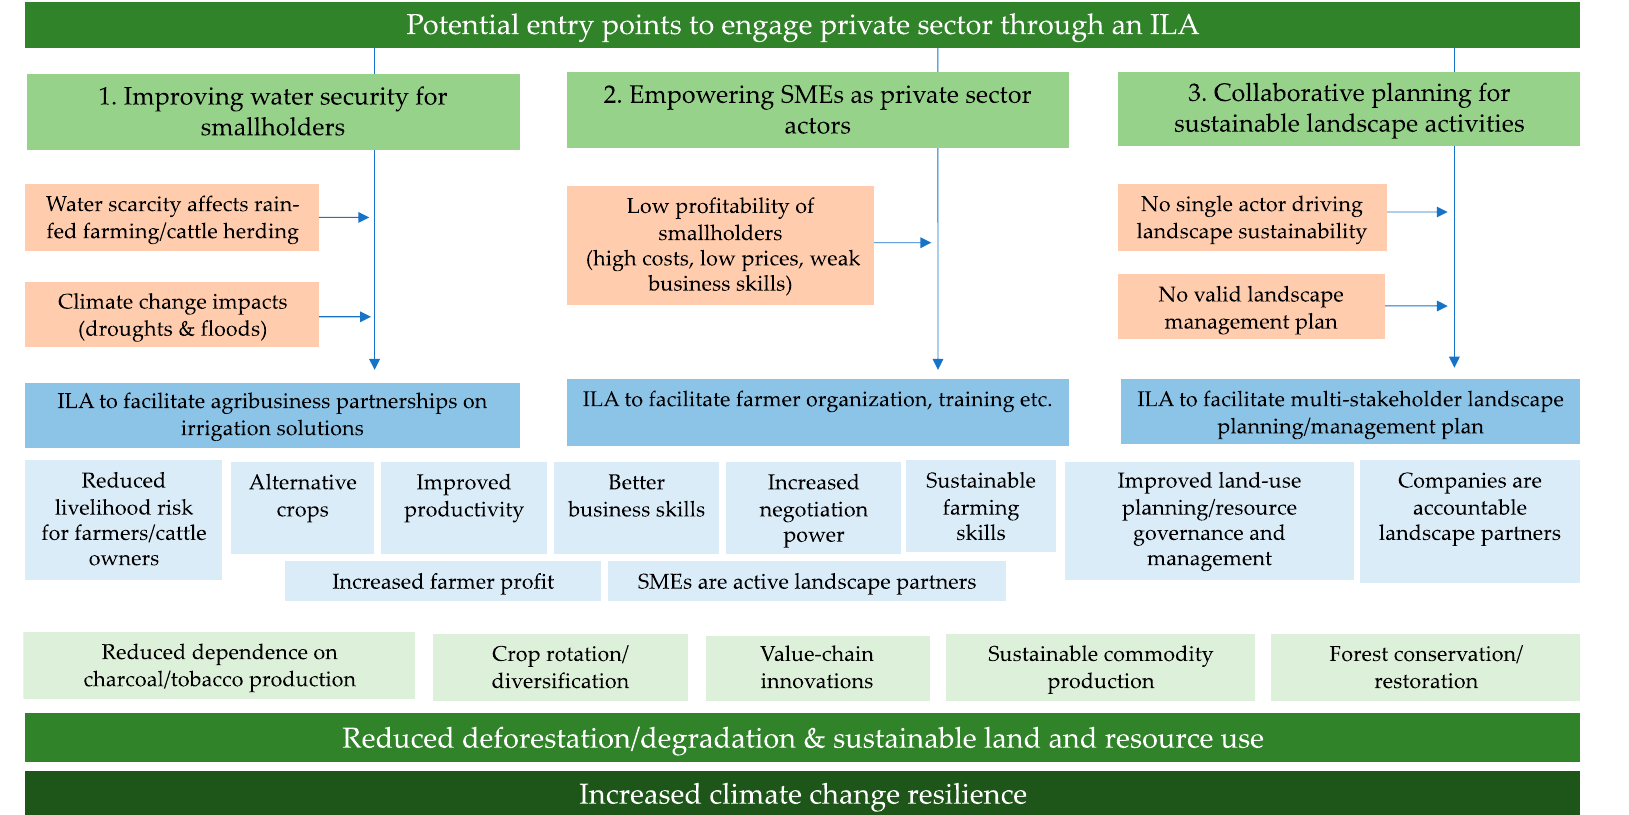
Figure 7. A flow chart summarizing the potential entry points for private sector engagement in Kalomo District (Source: Authors’ construct).